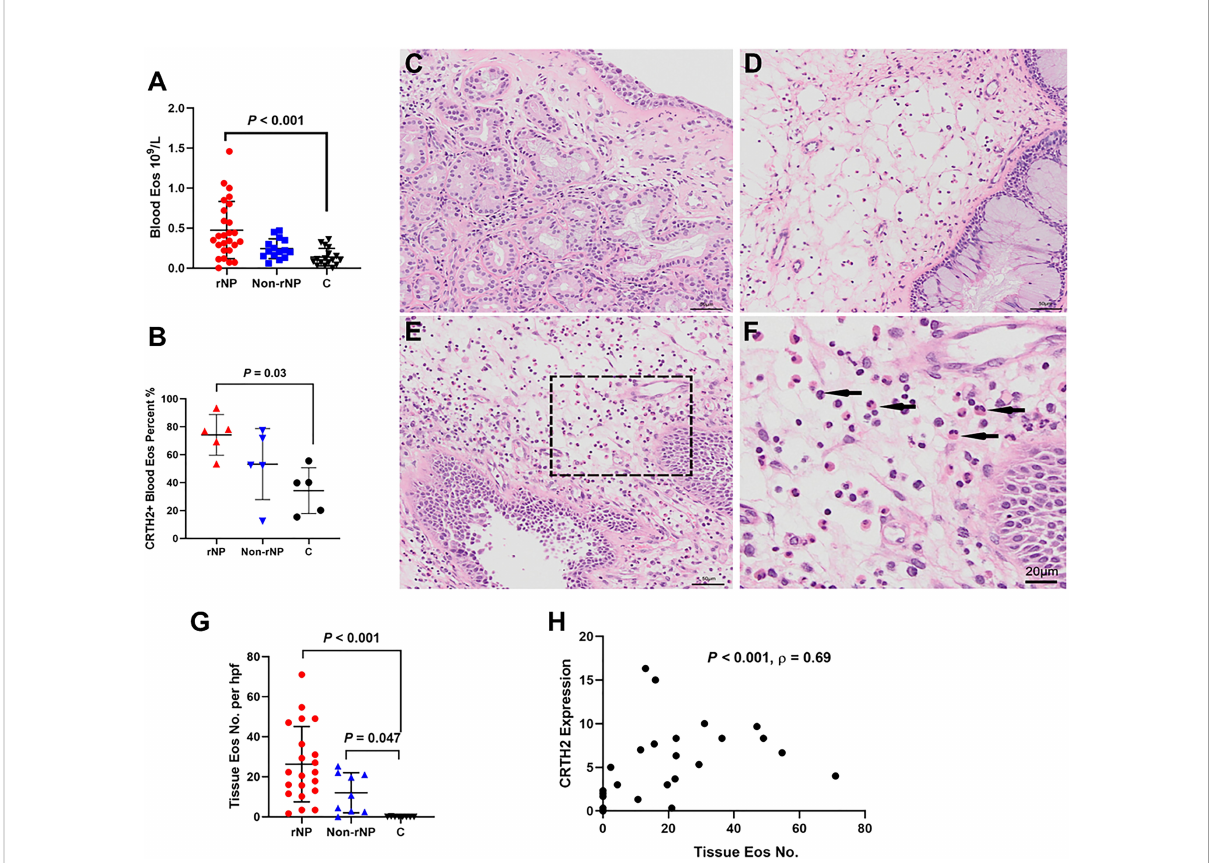
FIGURE 5 Over-expression of CRTH2 is associated with eosinophil in fl ammation in NP. (A) The blood eosinophil count in patients with rNP was signi fi cantly higher than that in the control group, while the difference between control and Non-rNP was not signi fi cant (rNP group: n = 26; Non-rNP group: n = 15; control group: n = 17). (B) Eosinophils of the rNP group presented higher CRTH2 expression than that of controls as shown by the higher percentage of CRTH2+ in blood eosinophils detected by fl ow cytometry (n = 5 per group). (C) HE staining of middle turbinate mucosa of the control group, (D) Non-rNP, (E) rNP, and (F) a closer view of picture (E) , with the black arrows indicating eosinophils. (G) Tissue eosinophils were further scored as mean number of eosinophils/200×hpf in HE stained sections. rNP (n = 21) and Non-rNP (n =